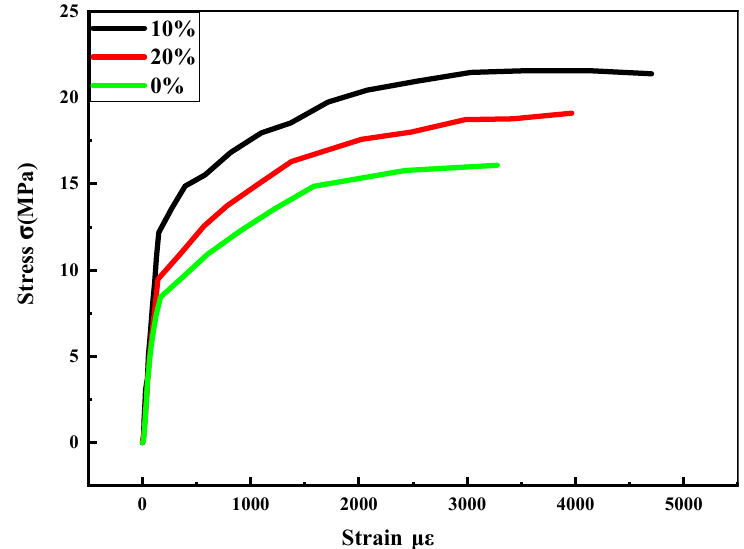
Figure 19. Stress–strain curve at the initial stress stage.